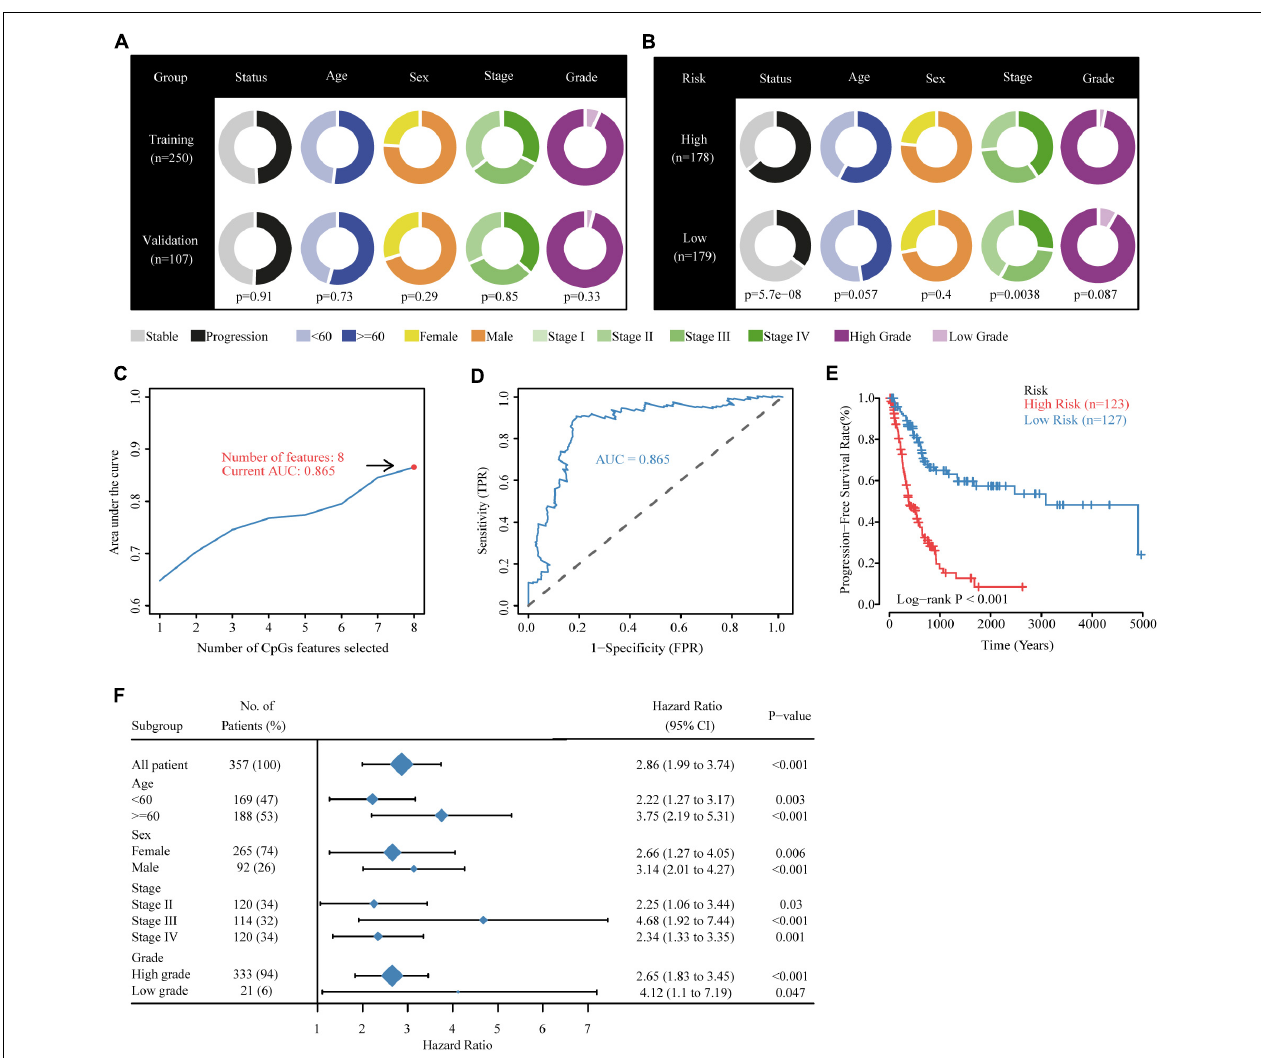
FIGURE 3 | Building the methylation risk score for bladder cancer (MRSB) in the training cohort. (A) Clinical characteristics of the training and validation cohorts. (B) Clinical characteristics of the high- and low-risk groups identified by MRSB. (C) Eight CpG predictive features had the highest discriminative power for high-risk and low-risk patients. (D) Area under the curve of the receiver operating characteristic curve for MRSB to distinguish between high- and low-risk groups. (E) Progression-free survival was significantly different between the high- and low-risk groups. (F) The prognostic value of MRSB in patient subgroups with different patient and clinical features.